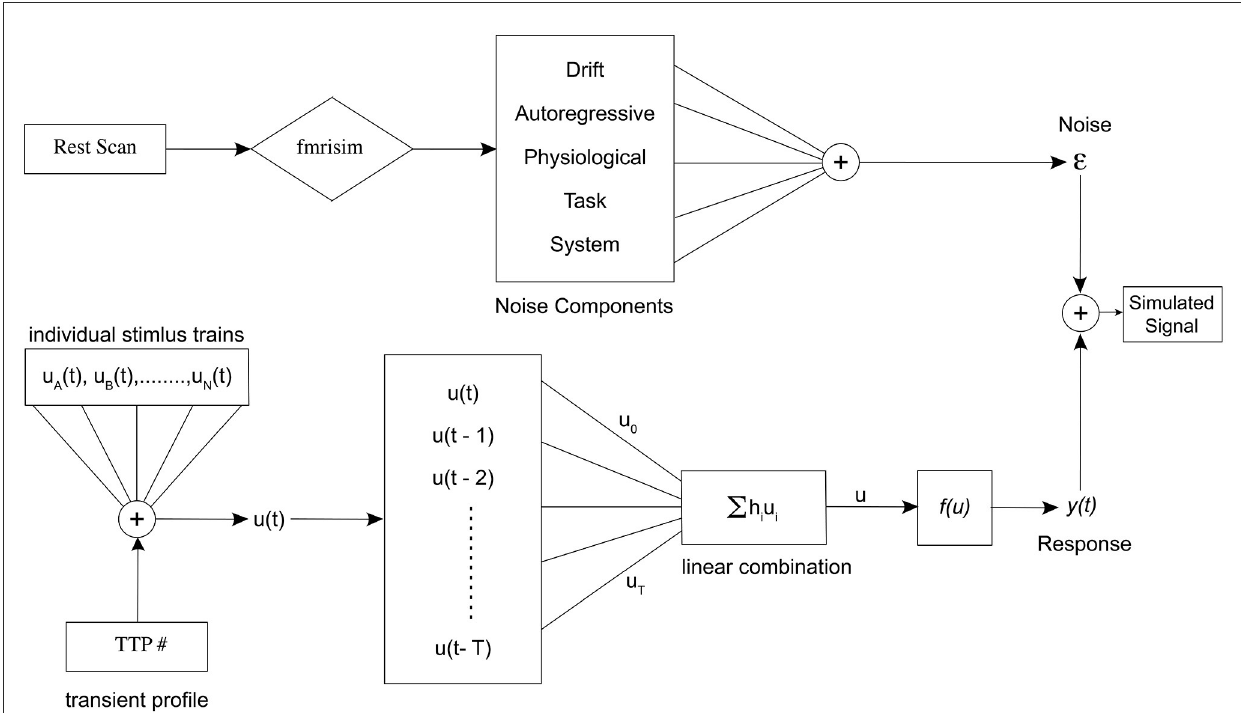
FIGURE2 Schematic representation of the entire simulation framework. Divided into two distinct pipelines, the top portion of the figure represents the noise pipeline, and the bottom shows the response signal pipeline. Finally, they are added together to obtain the final simulated signal for a specific set of